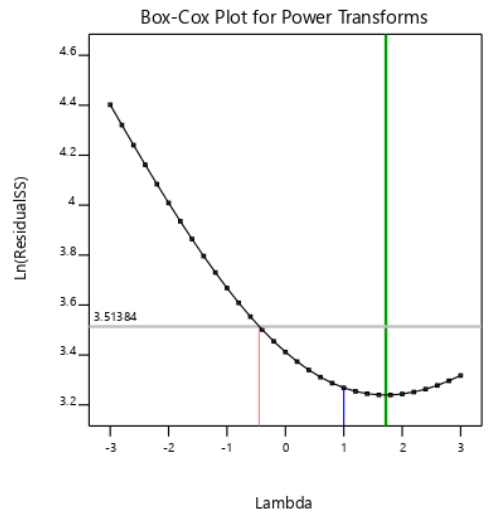
Figure 5. A Box–Cox plot representing the correlation coefficients for various optimized conditions. The green line shows the best lambda at value 1.72. The class interval for lambda (–0.45, 4.24) are shown. Values are mean ± SEM of triplicates and are significant at p < 0.05 for all treatments.